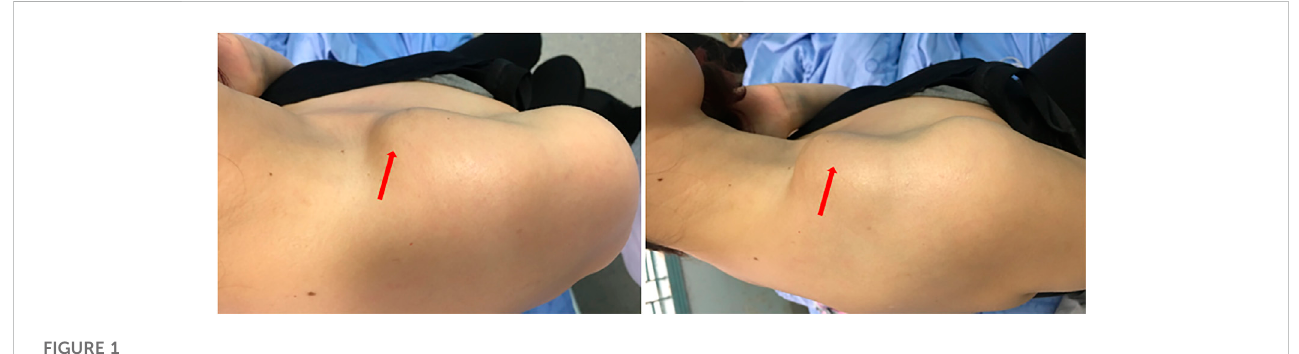
FIGURE 1 Photograph of the patient showing the right lateral clavicle